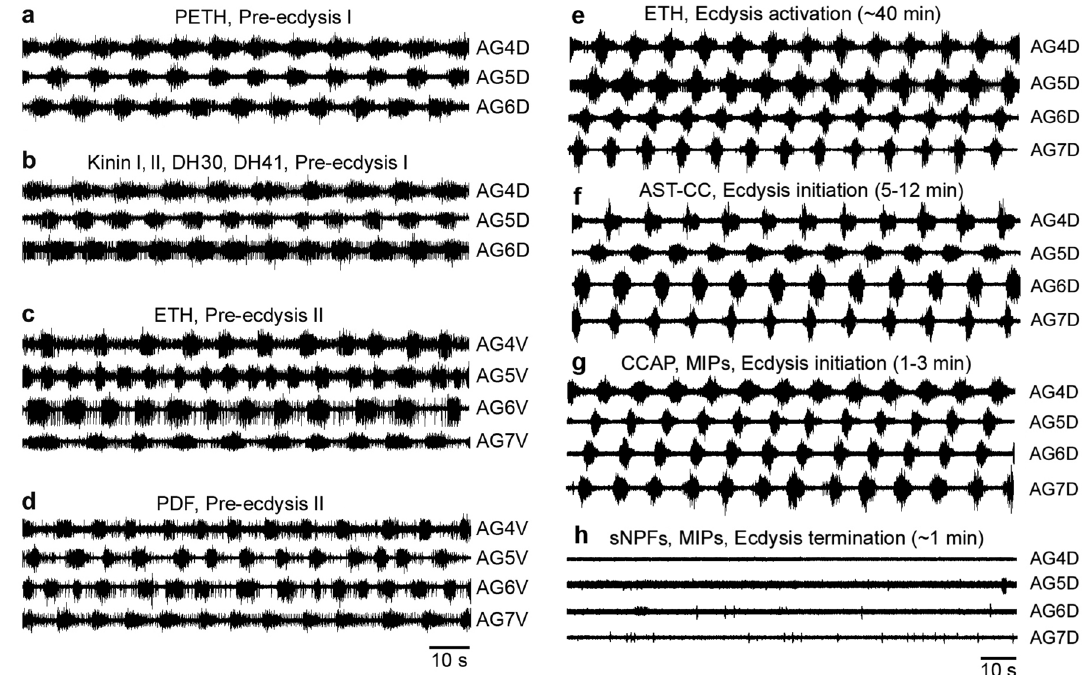
Figure 11. Effects of different peptides on the initiation or termination of pre-ecdysis or ecdysis bursts in the isolated CNS of pharate 5th instar larvae. ( a ) PETH-induced bursts characteristic for pre-ecdysis I recorded in dorsal nerves of the abdominal ganglia 4–6 (AG4-6D). ( b ) Very similar burst patterns were recorded in the desheathed AG4-6D after application of a mixture of kinins and DHs. ( c ) ETH-induced pre-ecdysis II bursts in ventral nerves of AG4-7 (AG4-7 V) that closely correspond to those evoked by PDF ( d ). ( e ) The isolated CNS of pharate larvae treated with ETH showed pre-ecdysis for ∼ 40 min and then switched to ecdysis motor patterns that were recorded in dorsal nerves of abdominal ganglia 4–7 (AG4-7D). ( f ) Application of AST-CC on the desheathed CNS evoked characteristic ecdysis bursts in 5–12 min without activation of pre-ecdysis motor program. ( g ) A mixture of CCAP and MIPs also induced ecdysis bursts in 1–3 min. ( h ) ETH-induced ecdysis activity were irreversibly terminated in ∼ 1 min after exposure of the desheathed CNS to a mixture of sNPFs and